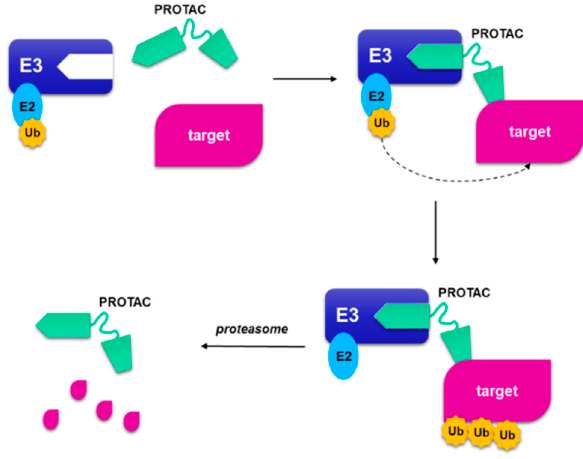
Figure 12. A schematic representation of proteolysis targeting chimera. The PROteolysis-TArgeting Chimera (PROTAC) is composed by a portion that binds to the ubiquitin ligase and a small molecule that binds to target protein, joined by a linker. When the targeted protein binds the small molecule, and the other part binds to E3 ligase, a ternary complex is formed. The following poliubiquitination of the target allows the proteasome to degrade the target protein and regenerate the PROTAC.